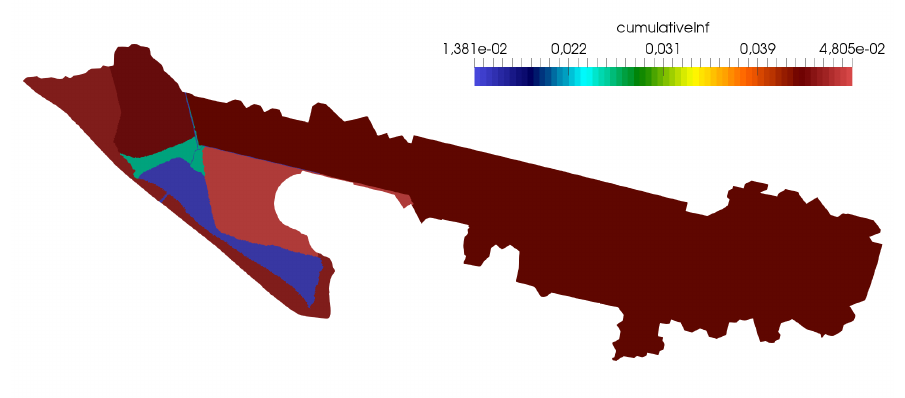
Figure 22. Case 3: Cumulative water infiltration F at t = 12